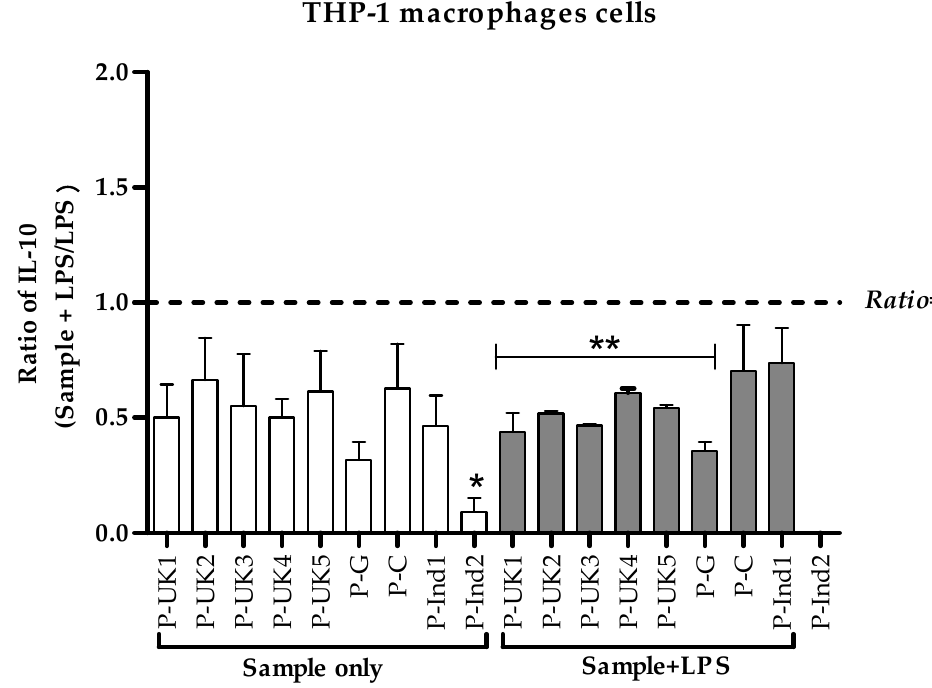
Figure 5. Effect of propolis extracts on the production of IL-10 cytokines by phorbol 12-myristate 13-acetate (PMA)-differentiated THP-1 cells in the absence and presence of LPS (0.5 µg/mL). P-UK1-5 and P-G combined treatments of propolis and LPS were statistically different from LPS alone ( n = 3). LPS: Lipopolysaccharides; *: Significant ( p < 0.05) when compared with untreated control; **: Significant ( p < 0.05) when compared with LPS; P-UK (1–5): Five propolis extracts from the UK; P-G: Propolis from Ghana; P-C: Propolis from Cameroon; P-Ind (1 and 2): Two Propolis extracts from Indonesia.